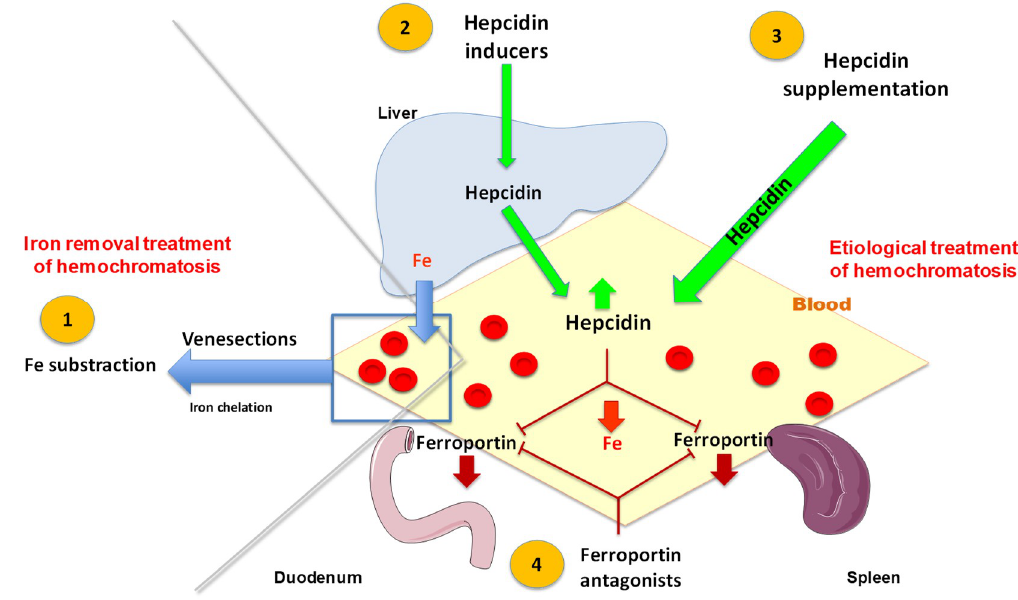
Figure 3. Schematic representation of currently used iron removal treatments during hemochromatosis and potential pathophysiological actions. (1) Iron depletive treatment is classically operated through repeated venesections that remove red blood cells. In some rare cases, iron chelators can be also used as complementary or suppletive treatment. (2) Hepcidin supplementation by endogenous or exogenous hepcidin. (3) Alternatively (4) the use of ferroportin antagonists could be also a way of treatment.